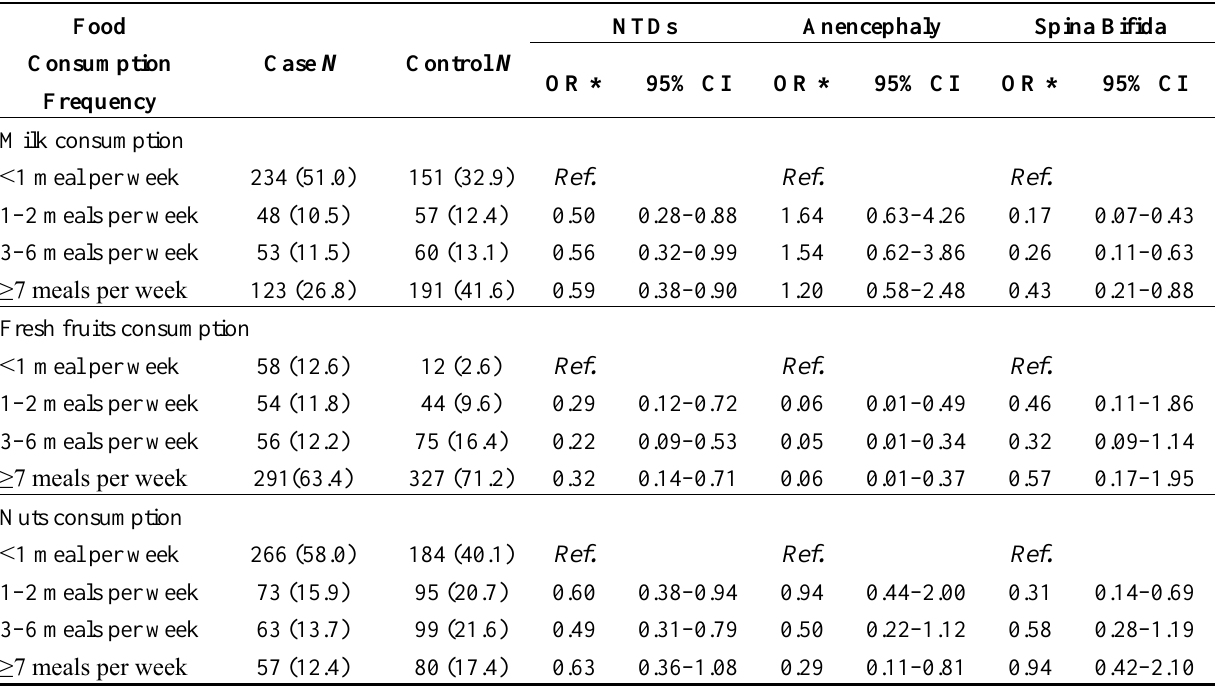
Table 4. Effects of food consumption frequency on all NTDs, anencephaly, spina bifida and